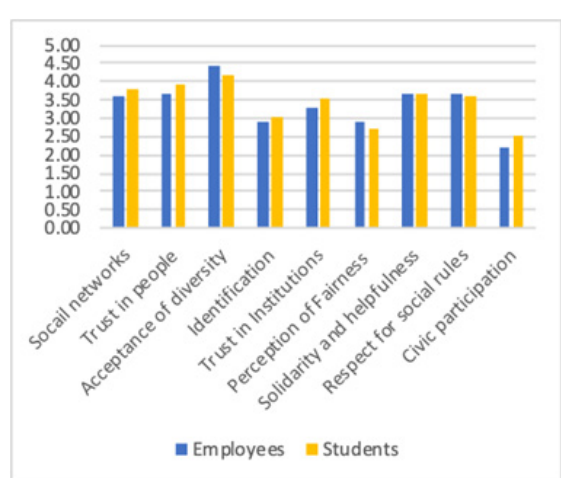
Figure 6. Comparison of social cohe- sion between employees and students by di-